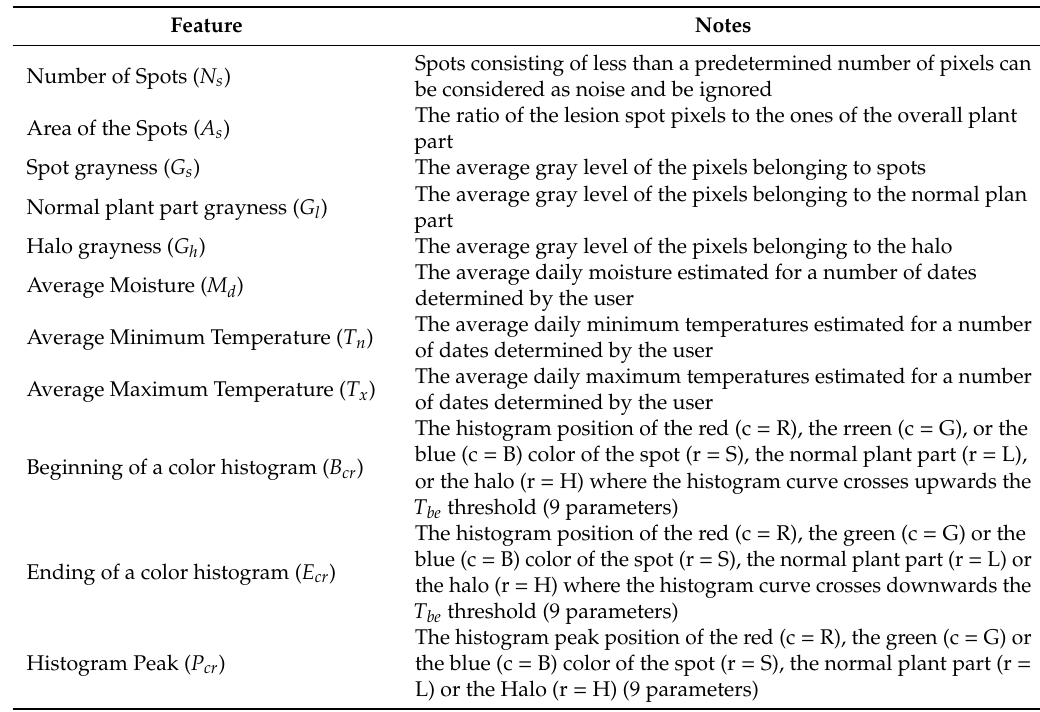
Table 1. The features used by the classification